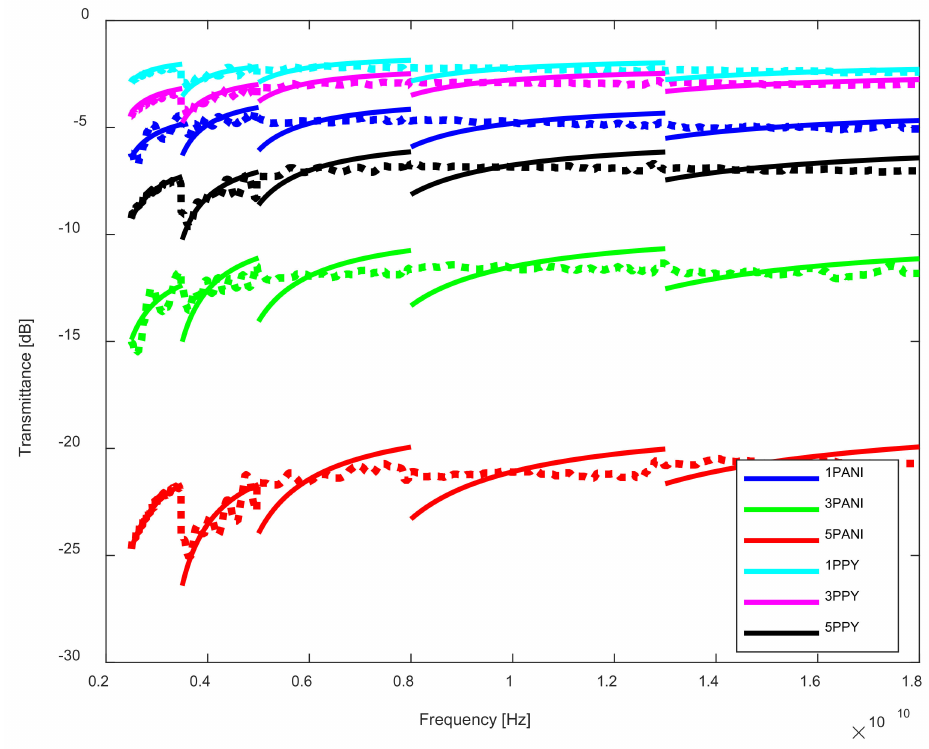
Figure 13. Model waveforms (solid) and measurement results (dotted) of transmittance in the tested frequency range from 2.5 to 18 GHz for textile samples printed with PANI and PPy conductive